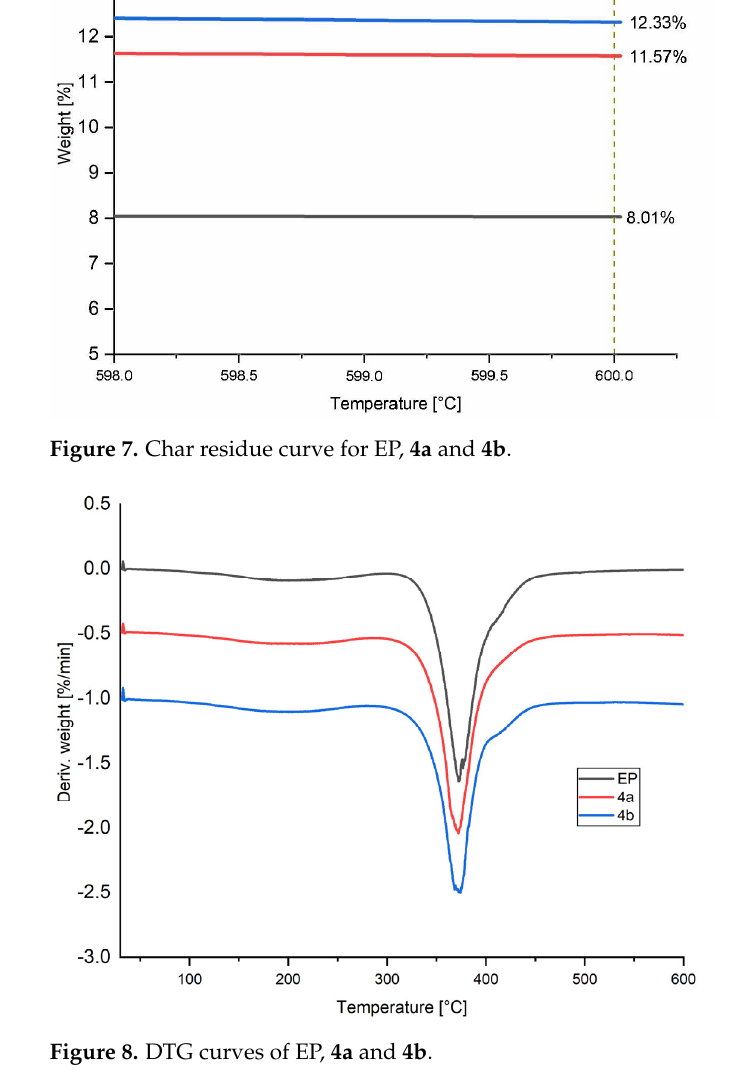
Figure 8. DTG curves of EP, 4a and 4b . Table 3. Thermal properties of EP and modified EP.